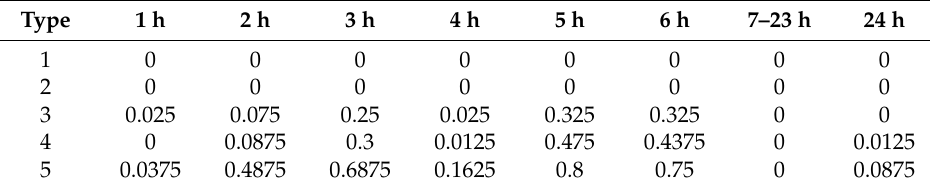
Table 6. The LLOAF states of different types of coal-fired units in the L2-SUC.